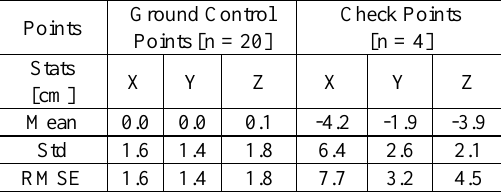
Table 4. Achieved accuracies for Nea Paphos site.